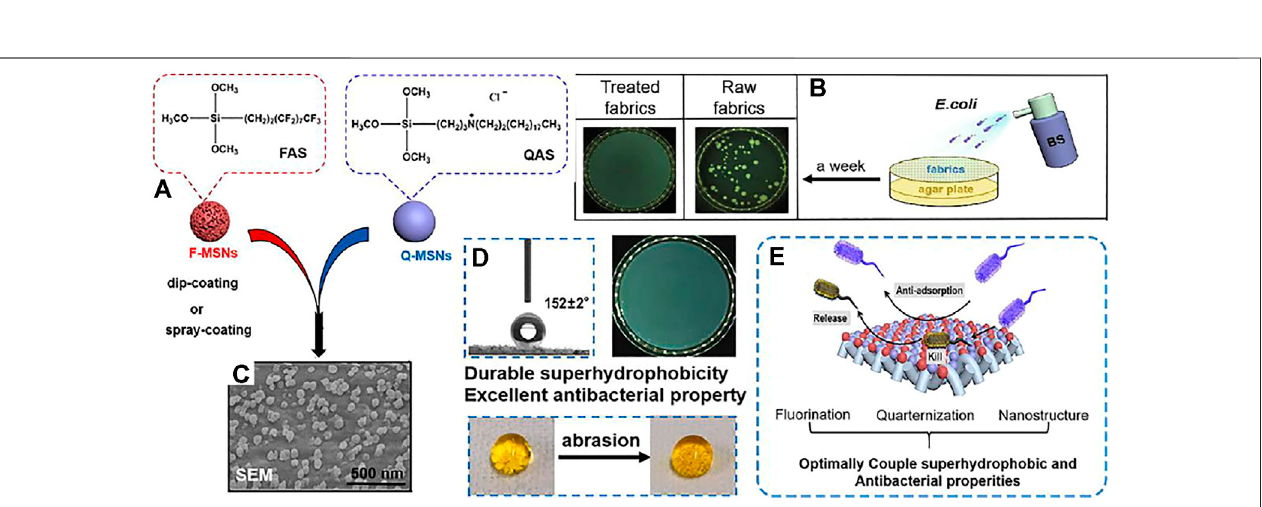
polyvinylidene fl uoride (PVDF) nano fi bers. The permeable vapor fl ux of the superhydrophobic APP/PVDF membrane is 53.1 kg/ (m 2 (cid:129) h), and the permeable conductivity is stable. At the same time, it has great applicability in MD desalination.